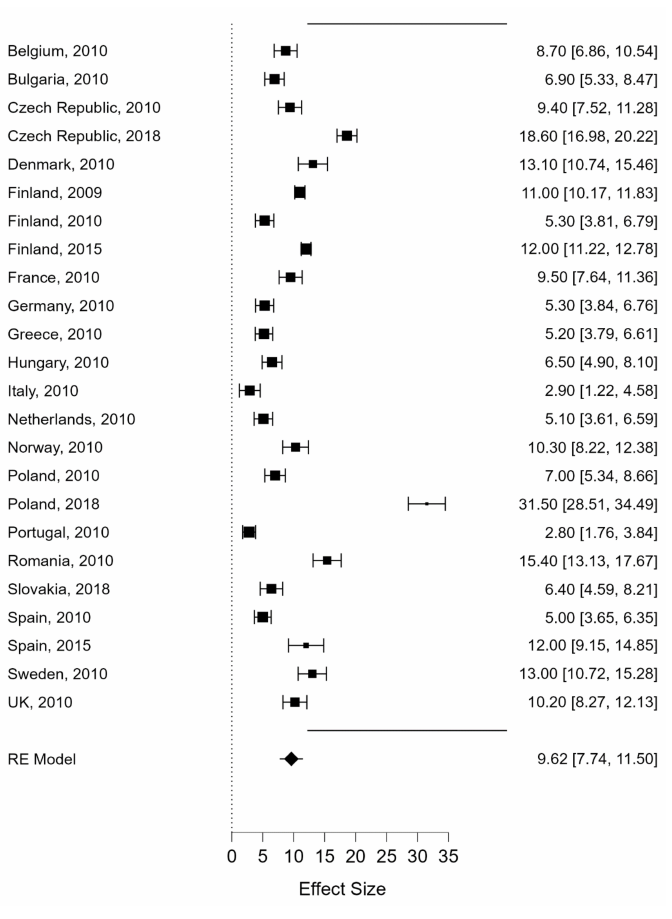
Figure 2. Prevalence estimates of Cybervictimization in member countries of the European